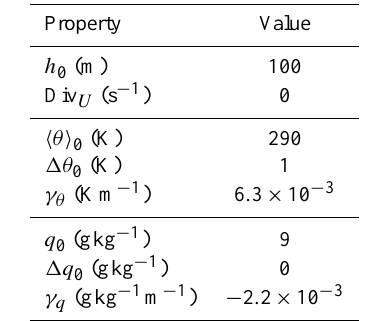
Table 5. Overview of the altered initial and boundary conditions for the case in which the residual layer is ignored compared to the standard case in Table 3. Listed are initial values (subscript 0), free tropospheric gradients, γ , and the large scale velocity divergence, Div U